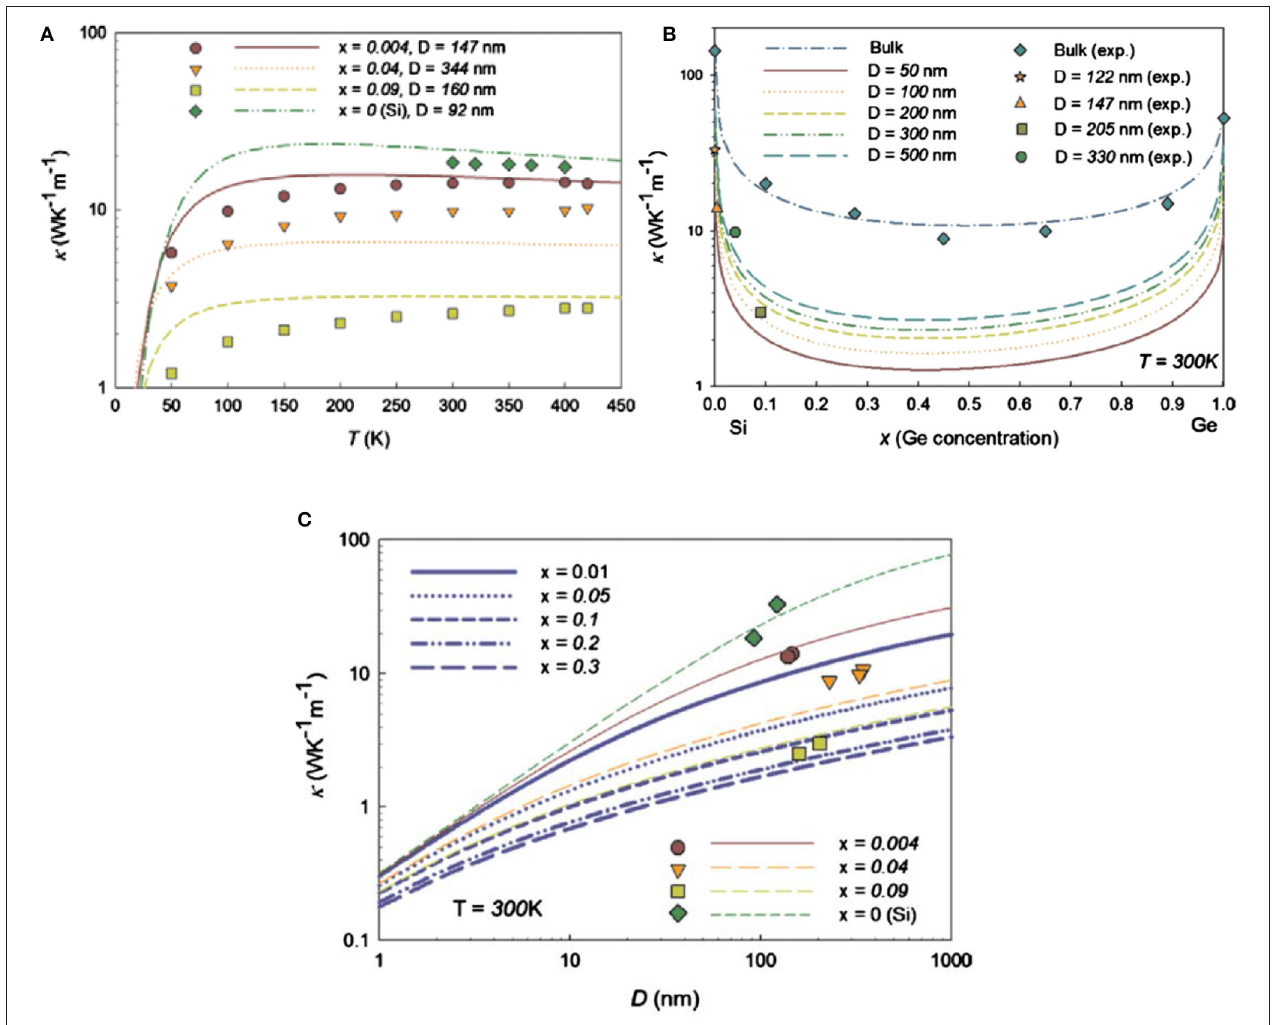
FIGURE 3 | Calculated and measured thermal conductivity of Si 1 − x Ge x NWs for different (A) temperatures, (B) Ge concents (at room temperature), and (C) diameter. The symbols are experient data from Kim et al. (2010) and Steele and Rosi (1958). Reprint from Wang and Mingo